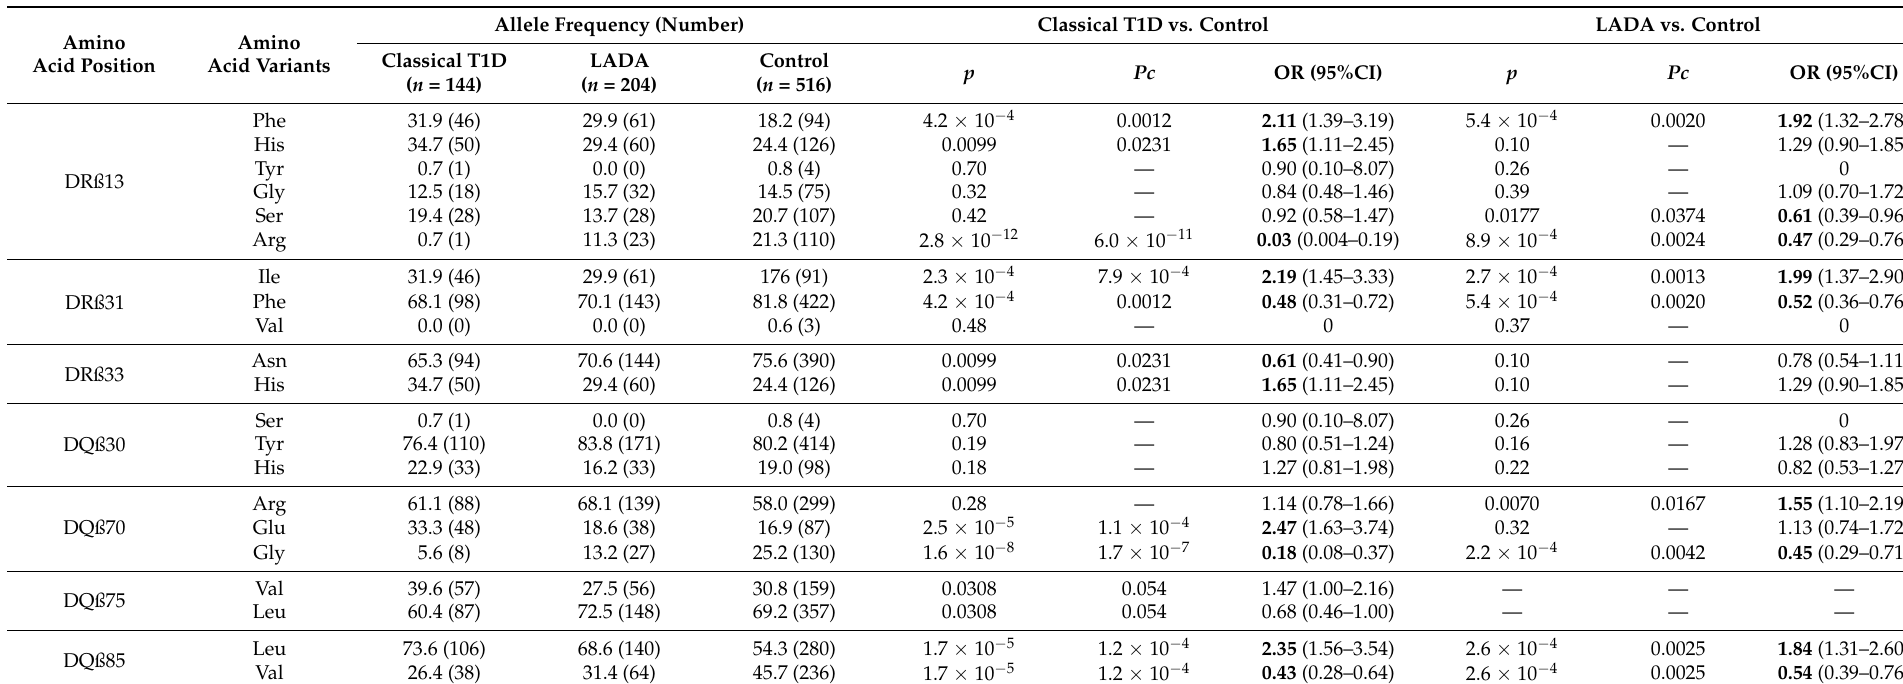
Table 2. HLA-DRB1 and -DQB1 amino acid frequencies at DR and DQ positions that showed an association with T1D and LADA in patients with classical T1D, those with LADA, and in